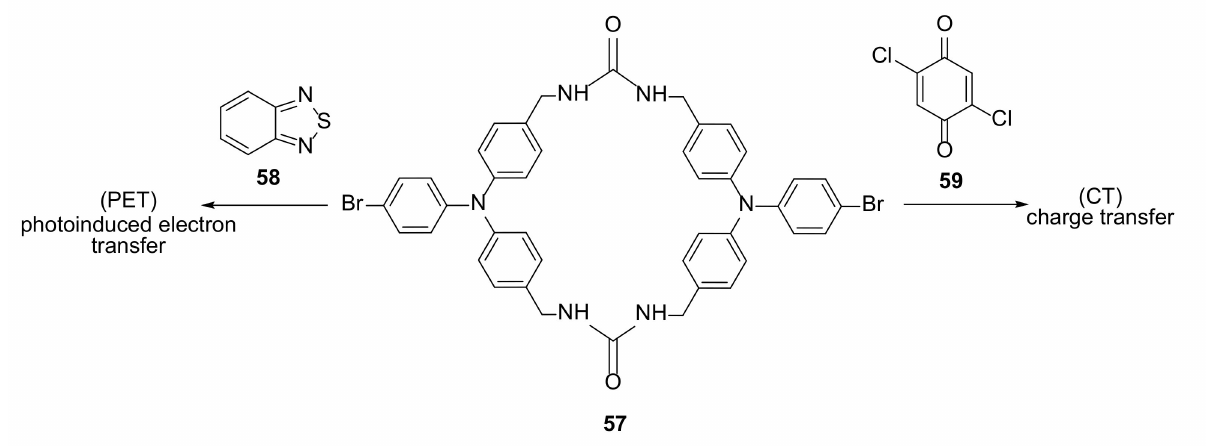
Figure 9. Electron-donor triphenylamine bis-urea macrocycle 57 with guest molecules enabling different electron-transfer mechanisms.